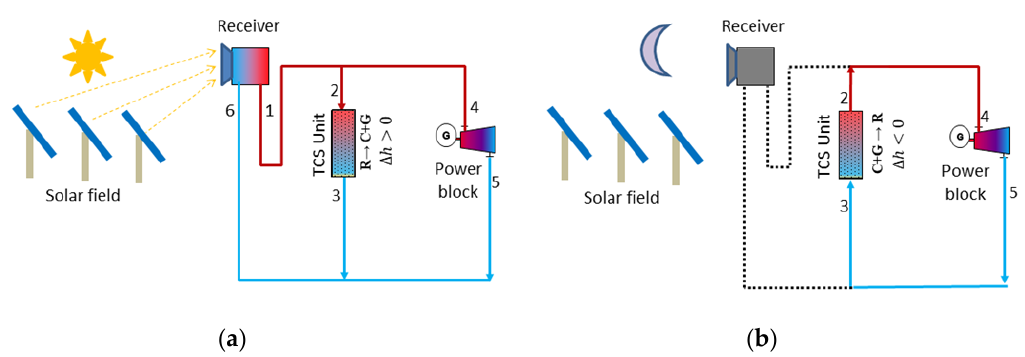
Figure 4. Conceptual scheme for the integration in parallel between thermochemical storage and power block, ( a ) charging operation (on-sun); ( b ) discharging operation (off-sun).